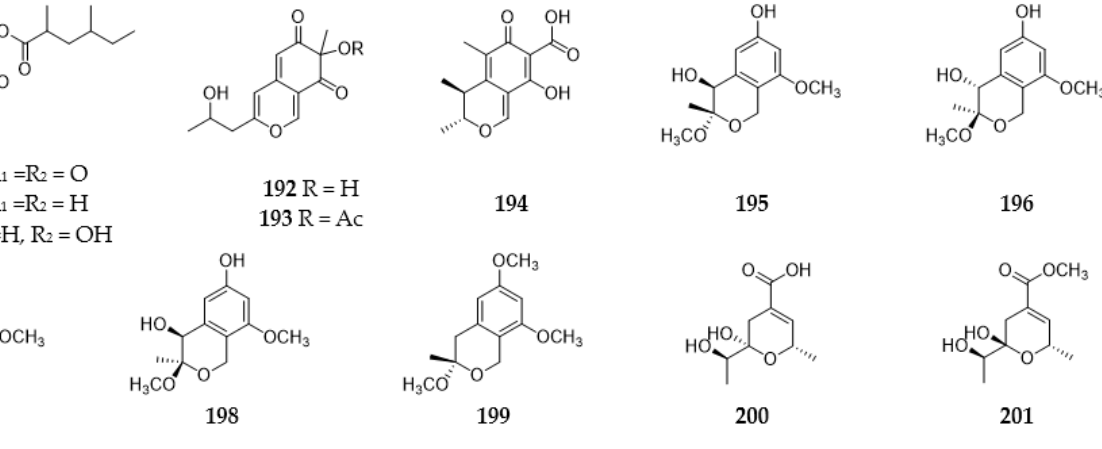
Figure 12. Aspergillus -derived pyrans ( 189 – 201 ).